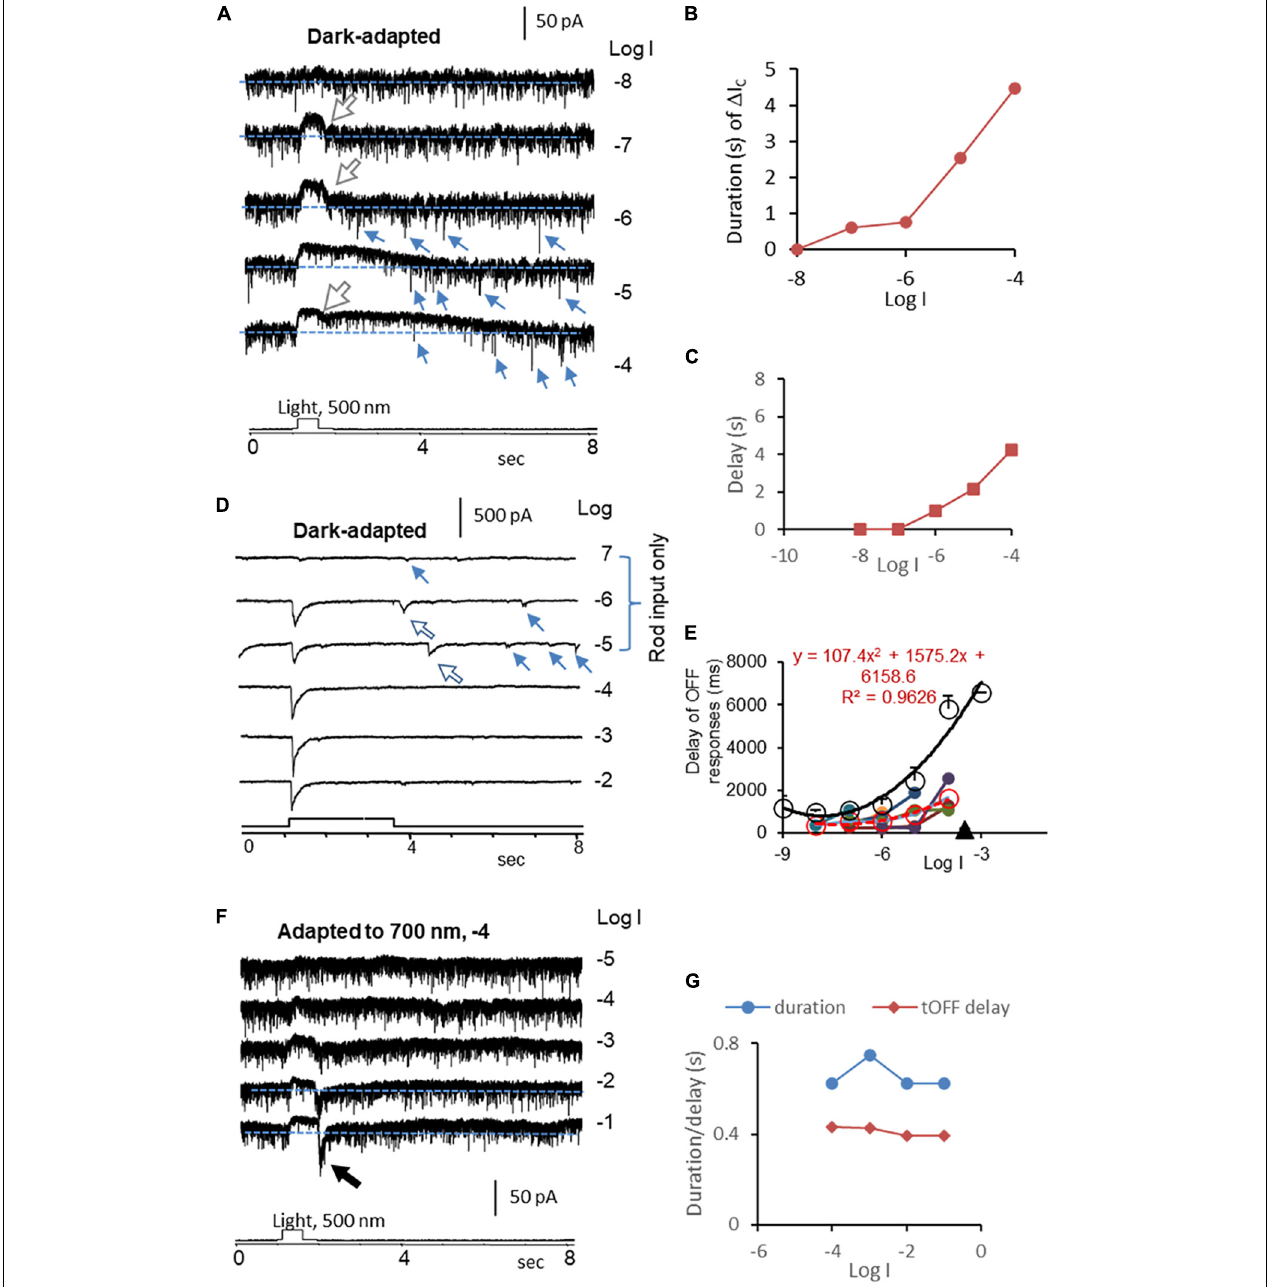
FIGURE 4 | Kinetics of rod-driven OFF responses in HBCs and RGCs. (A) A rod-driven HBC was recorded for light-evoked cation currents ( (cid:49) I C , Vh = –60 mV) at different light intensities (log I) in dark-adapted conditions. The cell shows a high frequency of the transient excitatory currents (TECs), some of which appear after light offset and display an amplitude ≥ the absolute value of (cid:49) I C at the light onset, namely gigantic (G) TEC offset (small arrow). (cid:49) I C is the outward sustained current, and the falling limb at the light offset (large white arrow) shows a short and stable delay. (B,C) The duration (B) of the (cid:49) I C in HBCs elongates upon increasing the light intensity like the light response of rods, and the first GTEC offset (C) delays progressively longer upon increasing the light intensity, resembling that of the rod Phase 3 ( Figure 2E ). (D) (cid:49) I C (Vh = –60 mV) in a dark-adapted ON-OFF RGC shows OFF response only in the scotopic range (large arrow). The major transient (cid:49) I C at the light offset ( (cid:49) I C − offset , large arrow) is followed by a few minor (cid:49) I C − offset s (small arrow). The latter appears at locations comparable with that of GTEC offset s in HBCs (A) and that of Phase 3 ( Figure 2E ) and action potentials ( Figure 1E ) in rods. (E) The delay time of the rod-driven OFF response varies among individual RGCs (color dot), and the mean value (red circle and dashed line) follows the trend of that of the rod Phase 3 (black circle and line) but generally faster. This supports that the scotopic (cid:49) I C − offset of RGCs is primarily mediated by rod-HBC synapses, and GTEC offset s of HBCs and the rod Phase 3 and action potentials play important roles. (F) The HBC in A shows transient (t) OFF response after being adapted to dim red light, when the duration of the entire (cid:49) I C and the delay of the (cid:49) I C at the light offset resemble that of cones (G) . The intensity of unattenuated [0 in log unit (log I)] 500 nm light from a halogen light source was 4.4 × 10 5 photons. µ m − 2 .s − 1 .